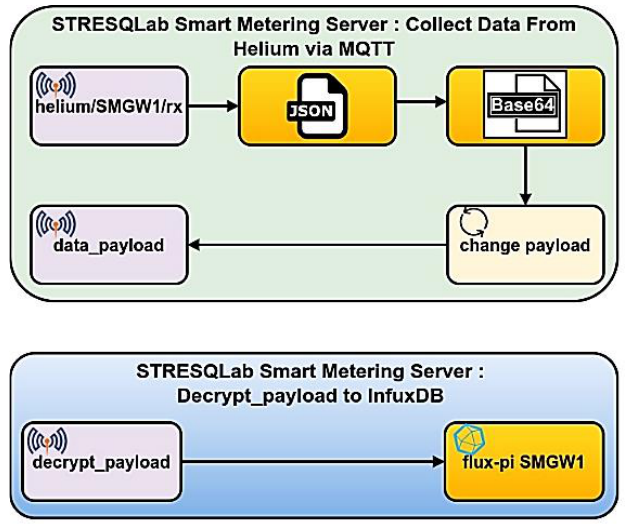
Figure 21. Node-Red: STRESQLab Smart Metering Server.